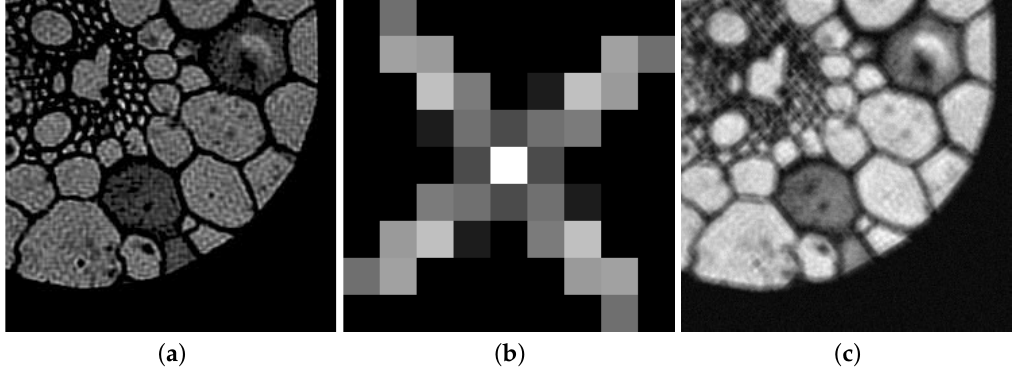
Figure 5. Grain test problem: ( a ) True image (246 × 246 pixels), ( b ) PSF (9 × 9 pixels), ( c ) Blurred and noisy image with 3% of white Gaussian noise (246 × 246 pixels).